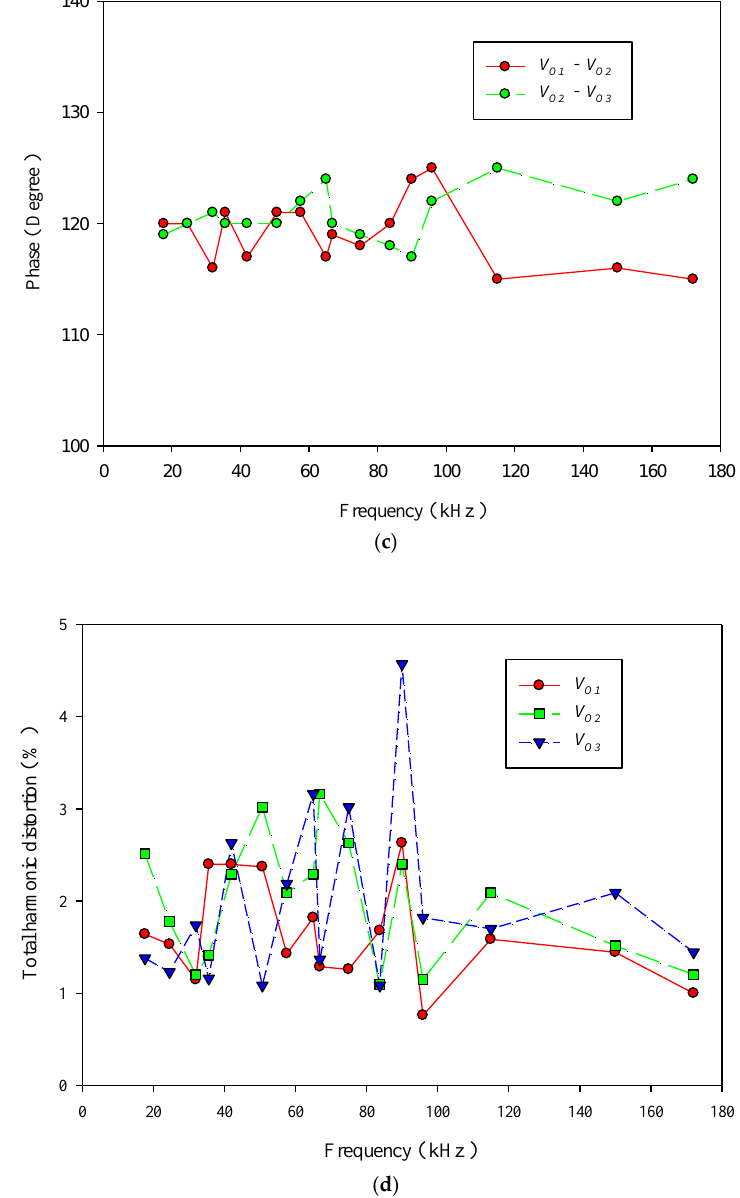
Figure 11. Experimental results of ( a ) FO by varying I B ( b ), magnitudes of voltage outputs, ( c ) phase difference of voltage outputs, ( d ) THD values of voltage